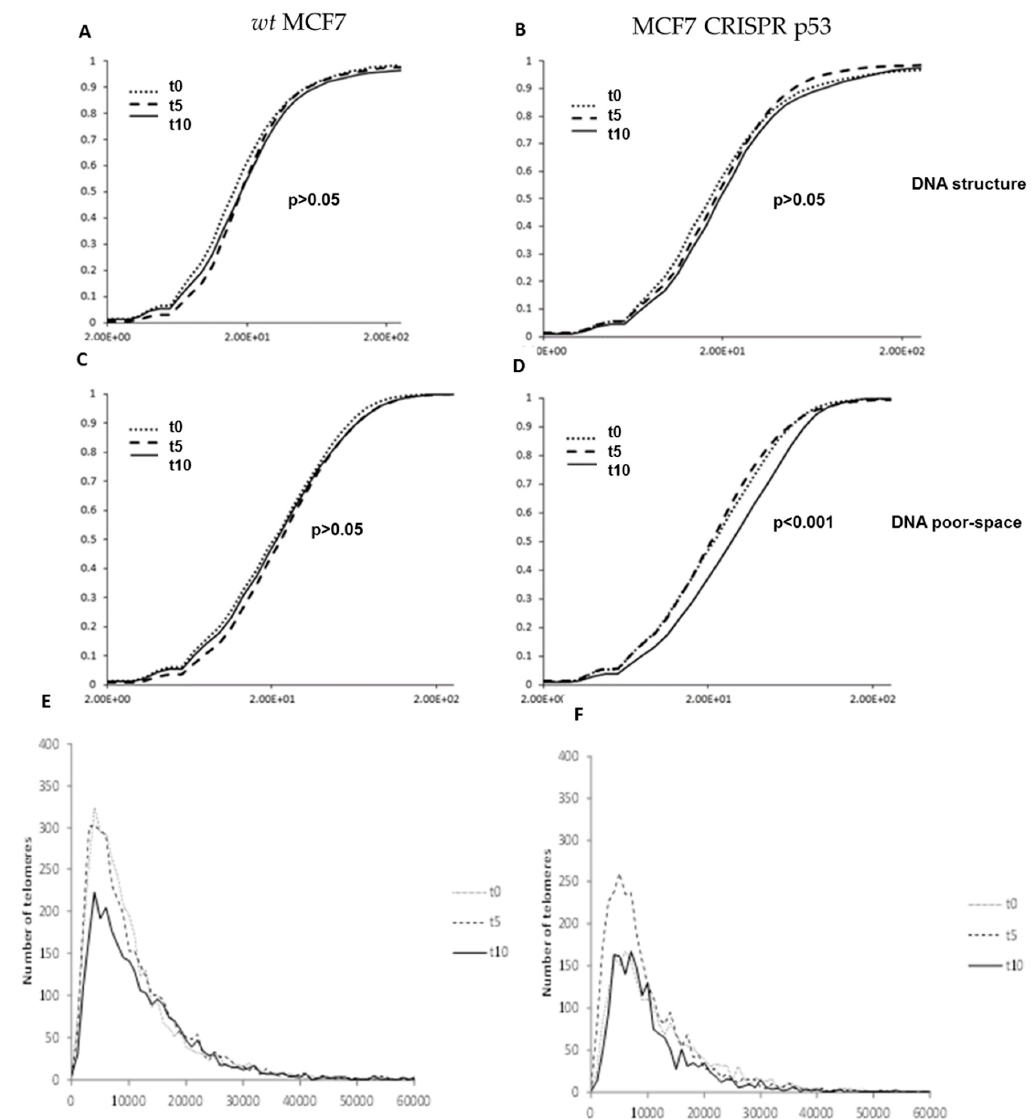
Figure 7. Changes produced by RITA in nuclear architecture in both wild-type and p53 knockout isogenic MCF-7 lines. Granulometry curves of DNA structure of wild-type MCF-7 ( A ) and p53 knockout MCF-7 cells ( B ). Granulometry curves of the structure of DNA-poor space of wild-type ( C ) and p53 knockout MCF-7 cells ( D ). Differences in 3D telomere distribution between p53 knockout and wild-type cells lines after RITA treatment (E).